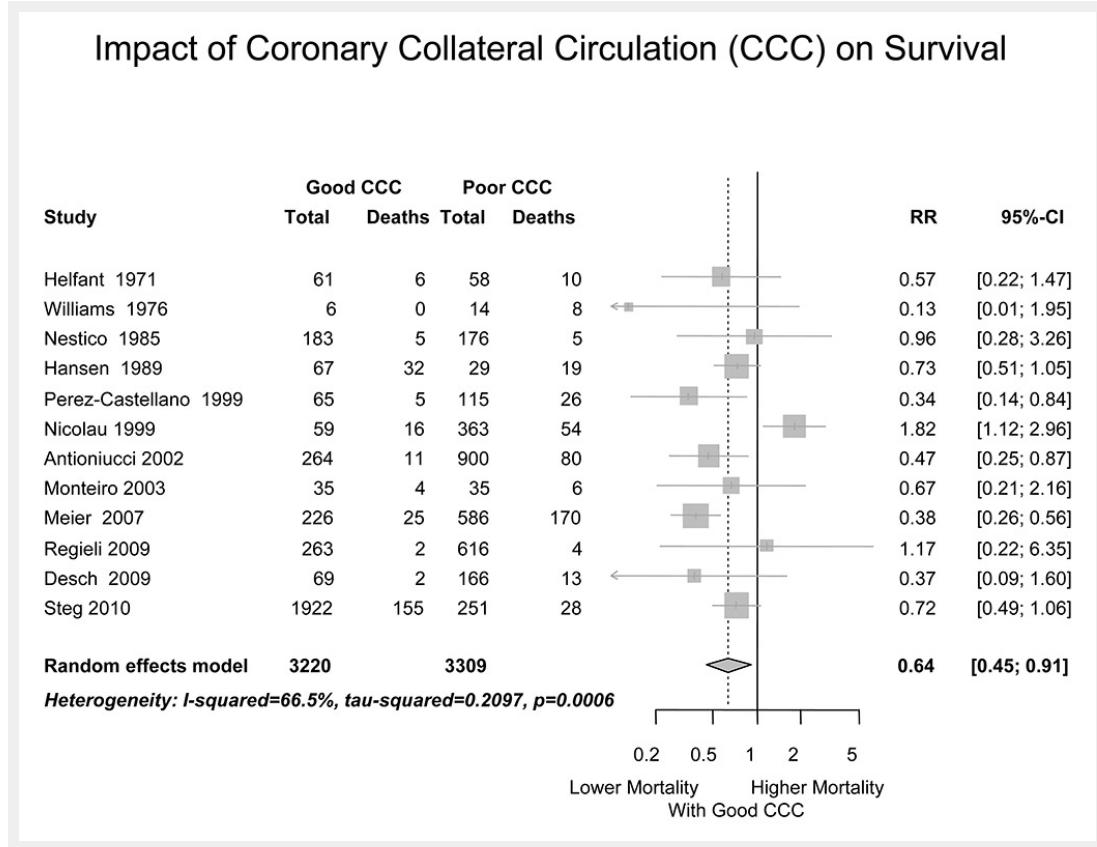
Figure 7 Forest plot of the effect of a “good” coronary collateral circulation on all-cause mortality of patients with coronary artery disease. In all studies except for one, “good” collaterals were defined angiographically as extensive filling of the main coronary branch of interest via anastomoses from an adjacent